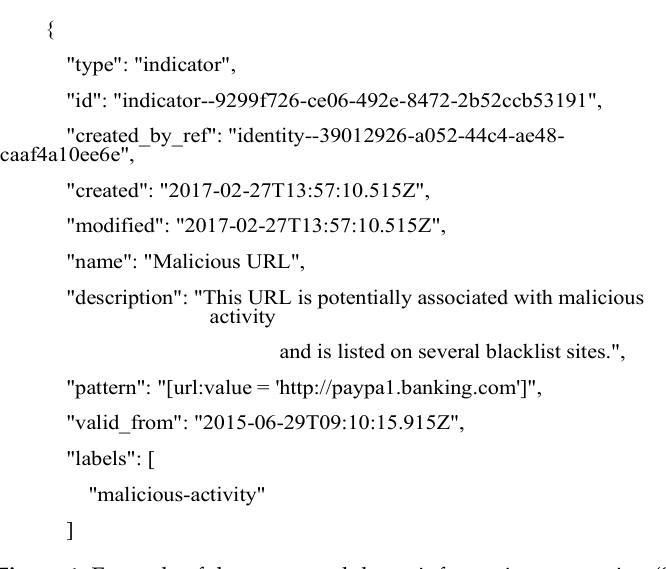
Figure 1. Example of the structured threat information expression (STIX) 2.0 Indicator SDO.